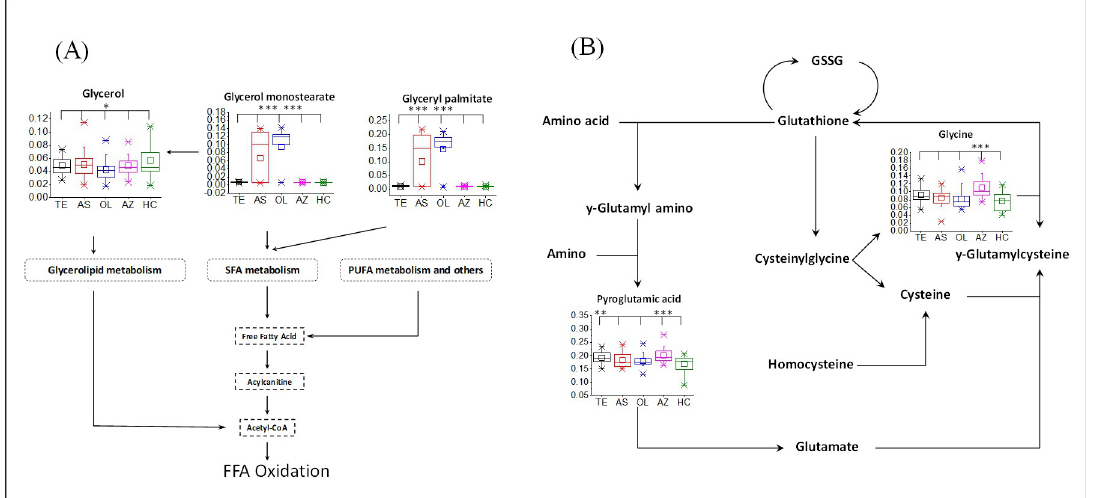
Fig 6. The overview of lipid metabolism and glutathione metabolism. (A) lipid metabolisms; (B) glutathione metabolism. SFA: saturated fatty acid; PUFA: polyunsaturated fatty acid.